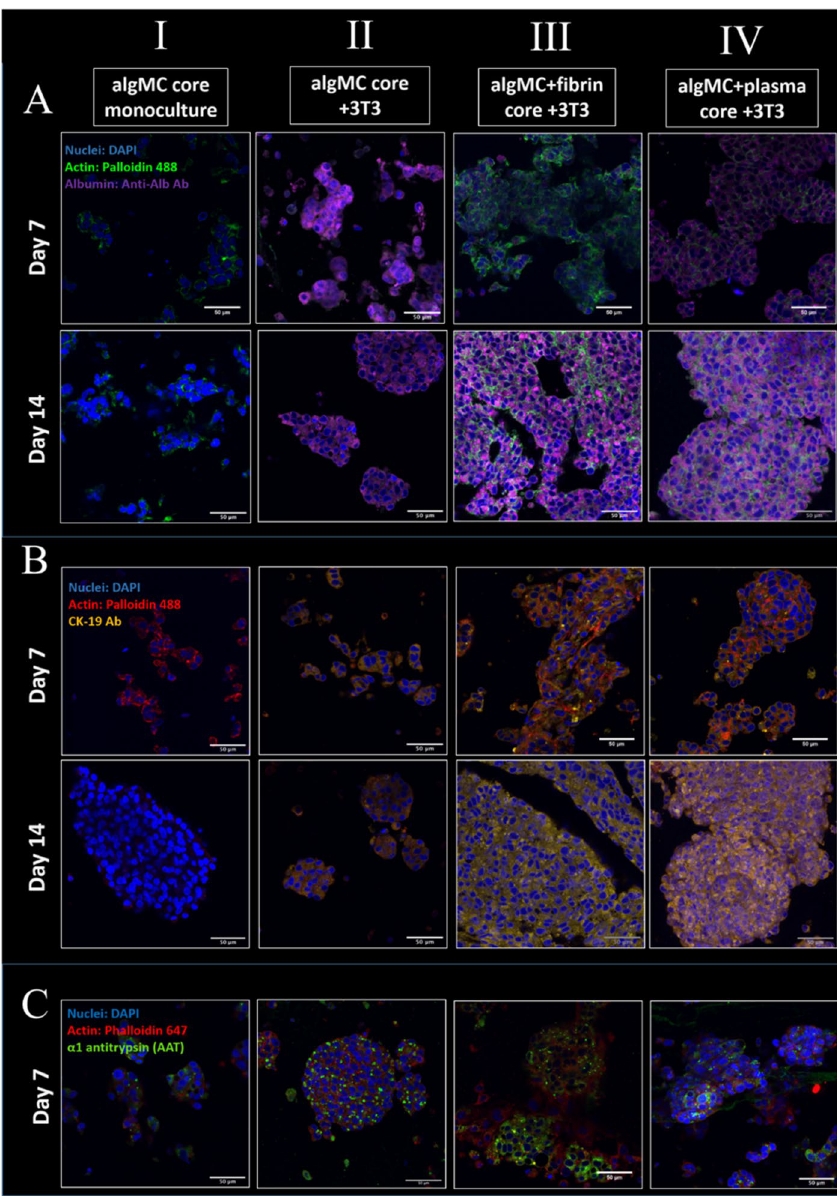
Figure 12. Cluster formation and biomarker expression of HepG2 embedded in shell compartment in monoculture (cell-free algMC core; I) and in co-culture with NIH 3T3 fibroblasts embedded in core compartment of different compositions (II-IV). ( A ) Confocal images of HepG2 stained for Albumin (purple), nuclei (blue) and cytoskeletons (green); scale bars 50 µm. ( B ) Confocal images of HepG2 stained for CK-19 (yellow), nuclei (blue) and cytoskeletons (red); scale bars 50 µm. ( C ) Confocal images of HepG2 stained for AAT (green), nuclei (blue) and cytoskeletons (red); scale bars 50